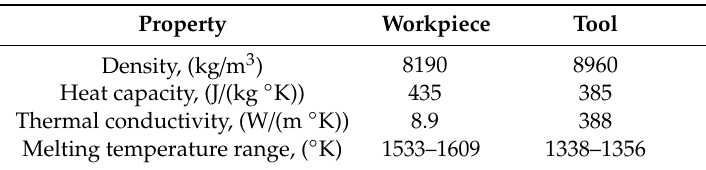
Table 2. Physical and mechanical properties of the workpiece and of the electrode material, for T = 298.15 °K and T = 291.15 °K, respectively [51–54].